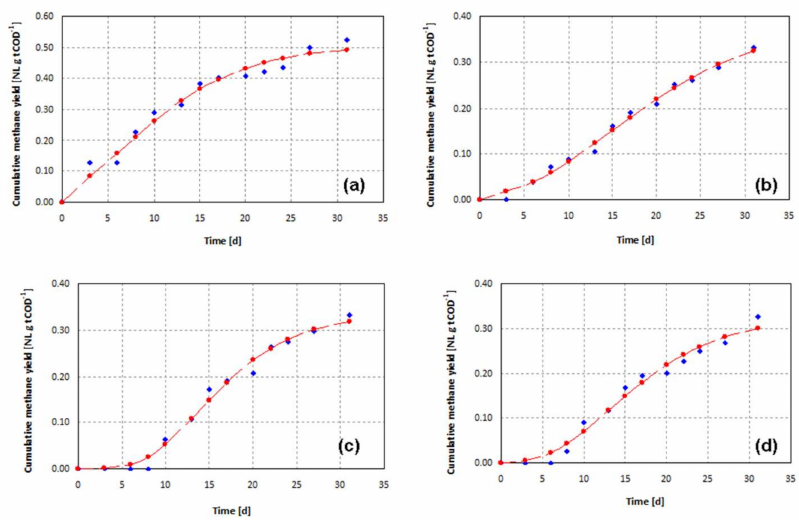
Figure 5. Measured and modeled (using the modified Gompertz Equation (5)) cumulative methane production of ( a ) c2, ( b ) A n-25-5 , ( c ) CT 10-40-0 , and ( d ) CTA 10-40-0 . The capital letters of the tests indicate the treatment, and the three letters / numbers identify the value of the operational parameter, pH, temperature, and air flow rate; C = chemical; T = thermal; A = aerated; c2 = raw SW used as control; and tCOD = total COD. The experiments were carried out in